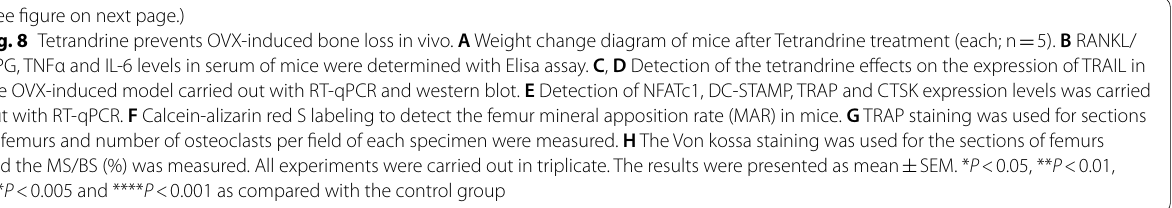
SEM. * P < 0.05, ** P < 0.01, *** P < 0.005 and ±